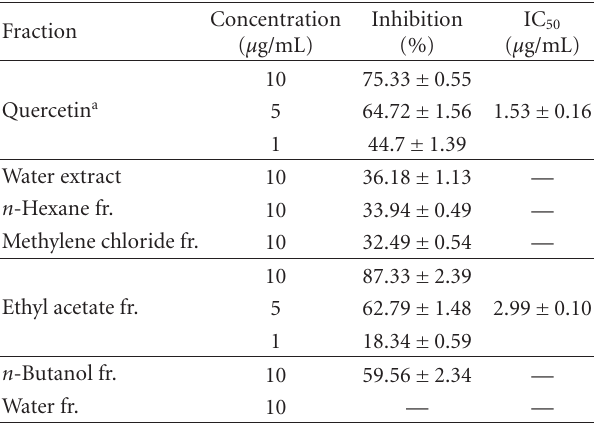
Table 2: Inhibitory e ff ects of the compounds isolated from the P. vulgaris L. on rat lens aldose reductase (rAR) and human recombinant aldose reductase (rhAR).